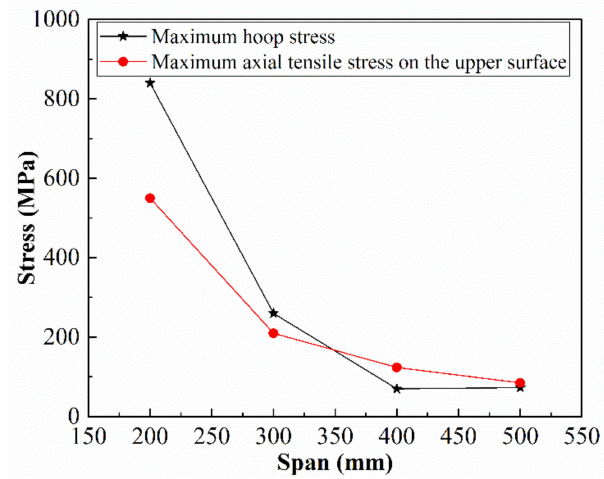
Figure 17. E ff ect of the span to the residual